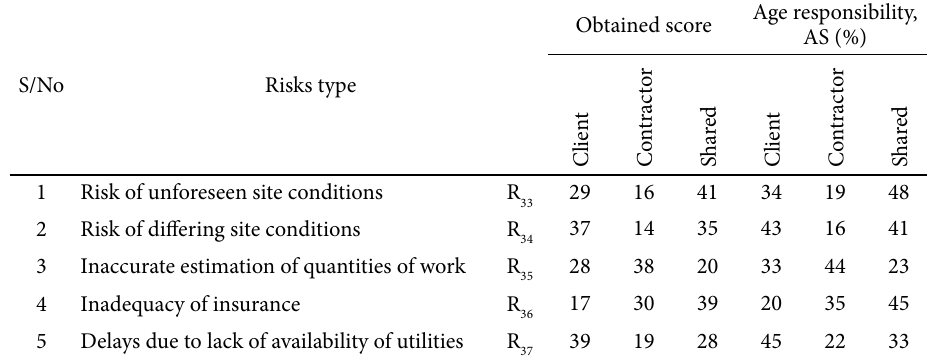
Table 4. Undecided